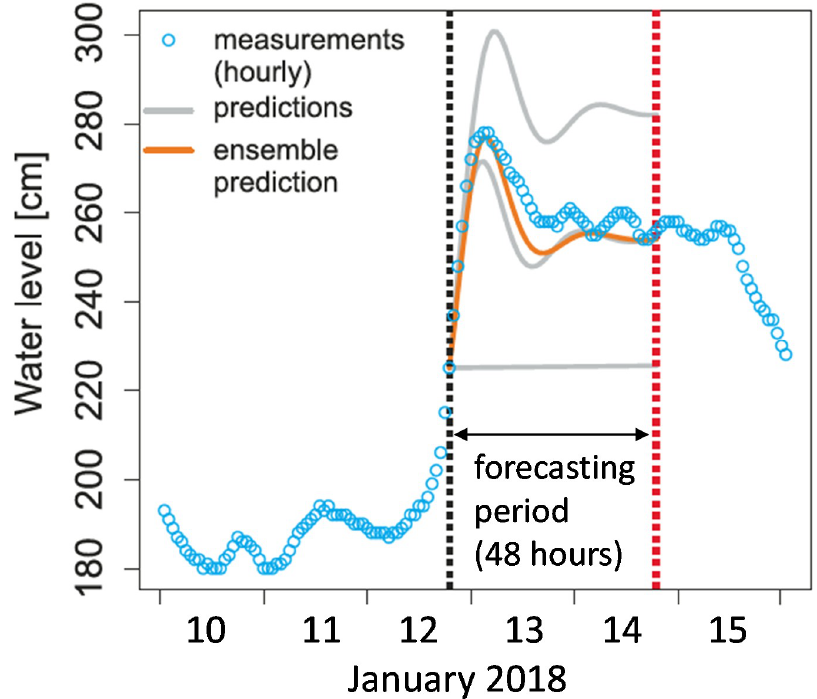
Figure 15. Multi-model ensemble prediction of stages together with forecasts based on ensemble members compared to measurements that were observed.